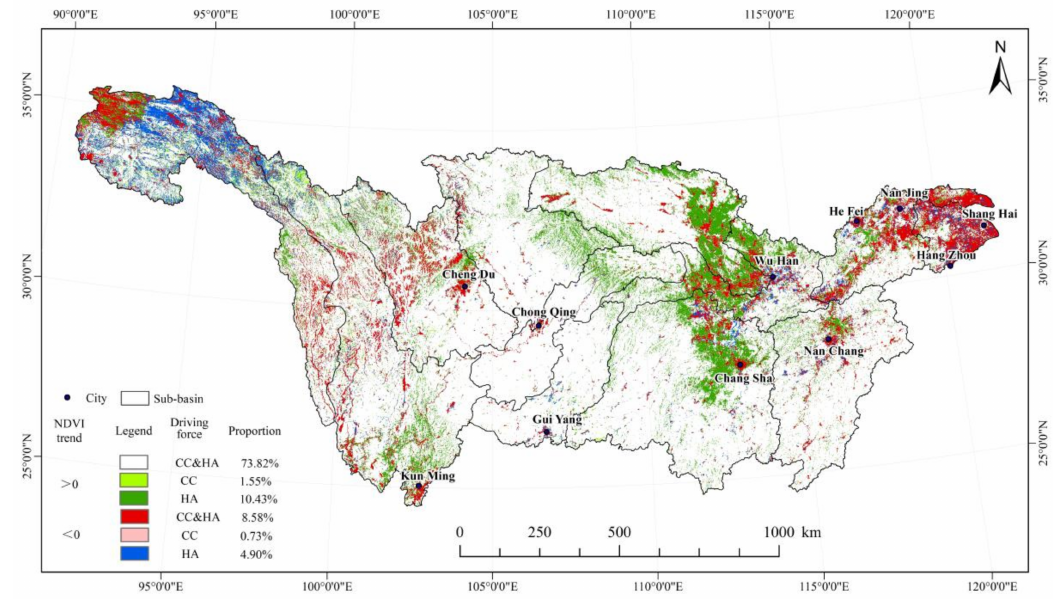
Figure 9. Drivers of vegetation cover change in the Yangtze River Basin from 2000 to 2019 (CC and HA represent climatic change and human activities,